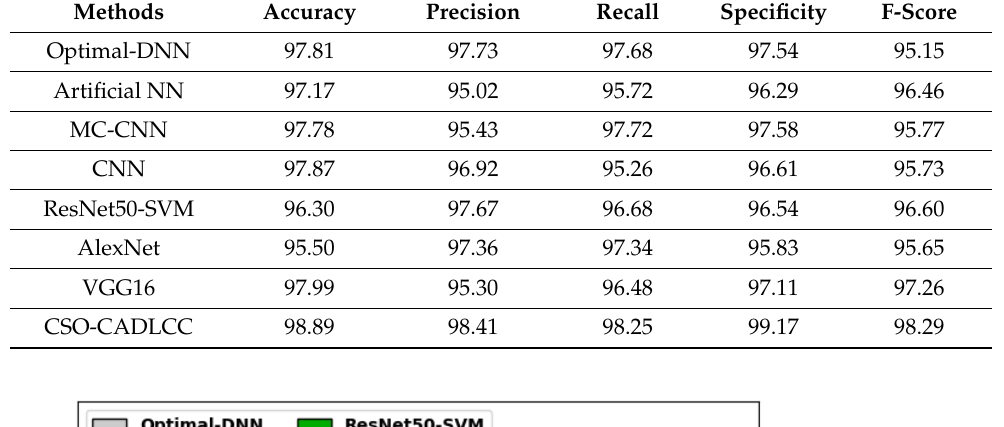
Table 2. Comparative analysis between the CSO-CADLCC technique and other recent algorithms.